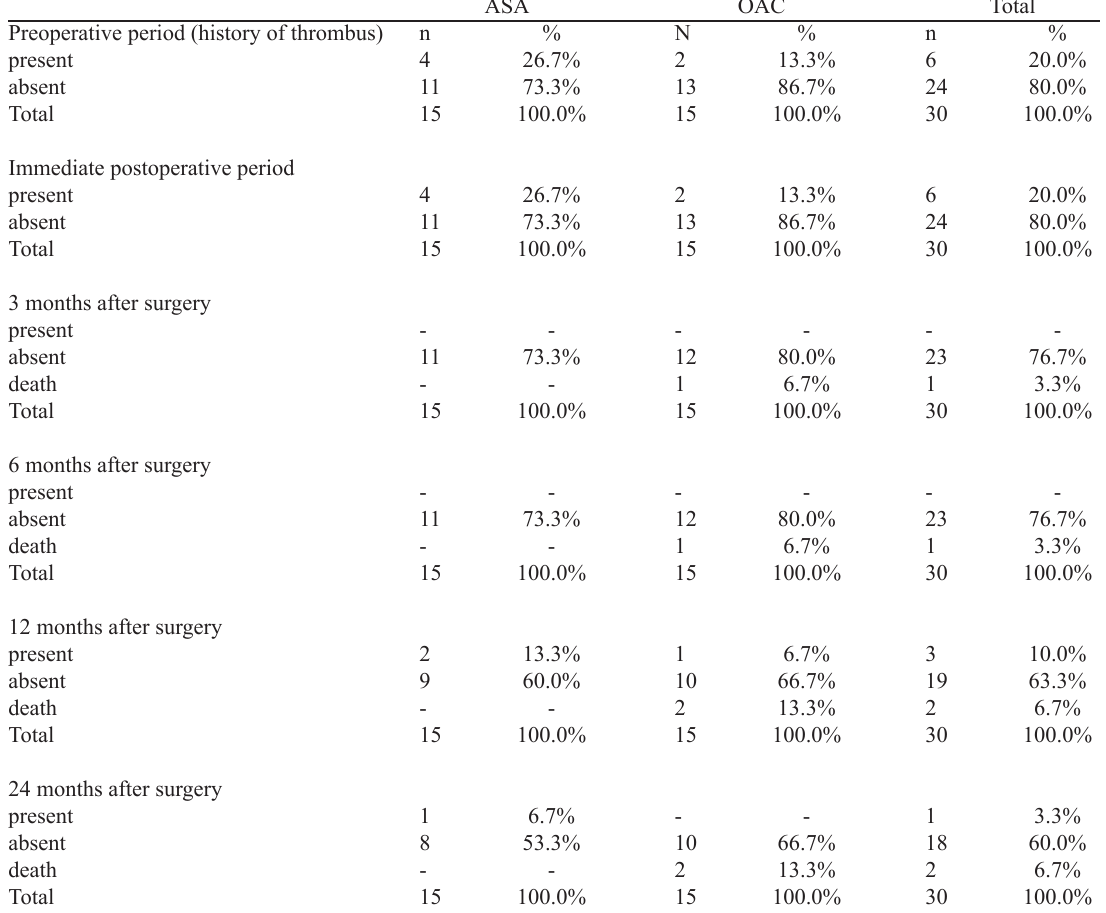
Table 3. Distribution of the occurrence of thrombosis in children of ASA and ACO groups, second phase. Preoperative period (history of